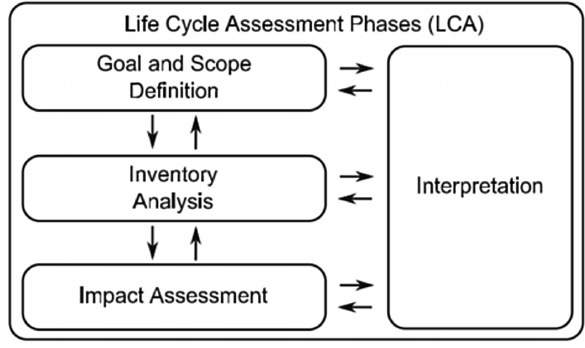
Figure 4: General frame of Life Cycle Assessment [27]